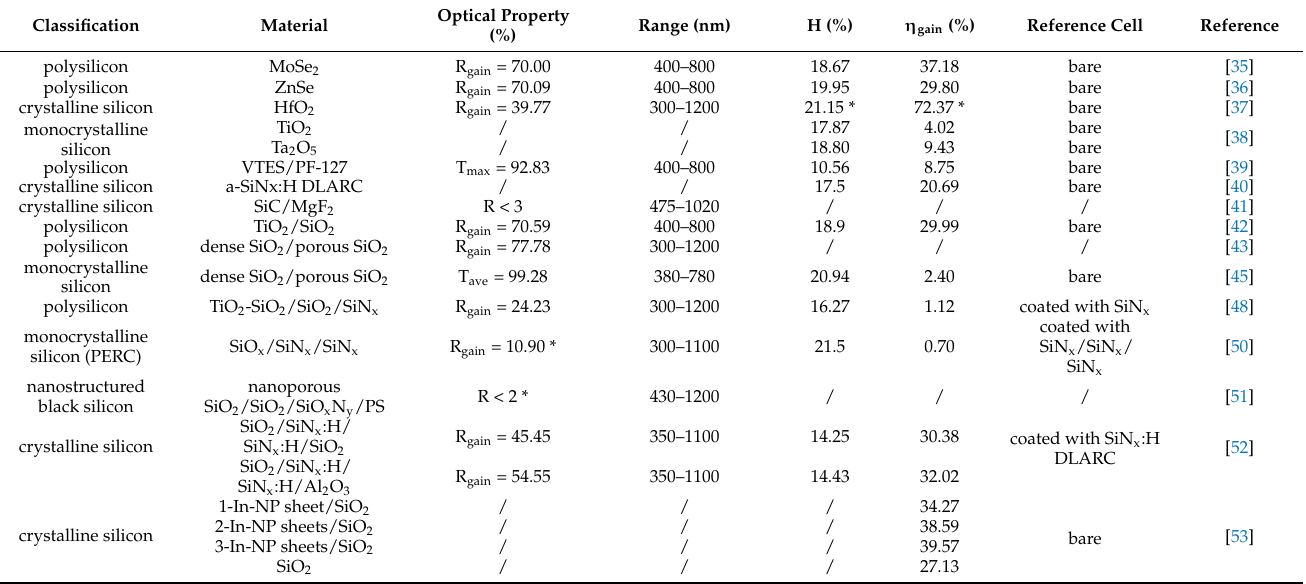
Table 1. The optical and electrical parameters of the first generation of solar cells with different ARCs. (* represents the simulated